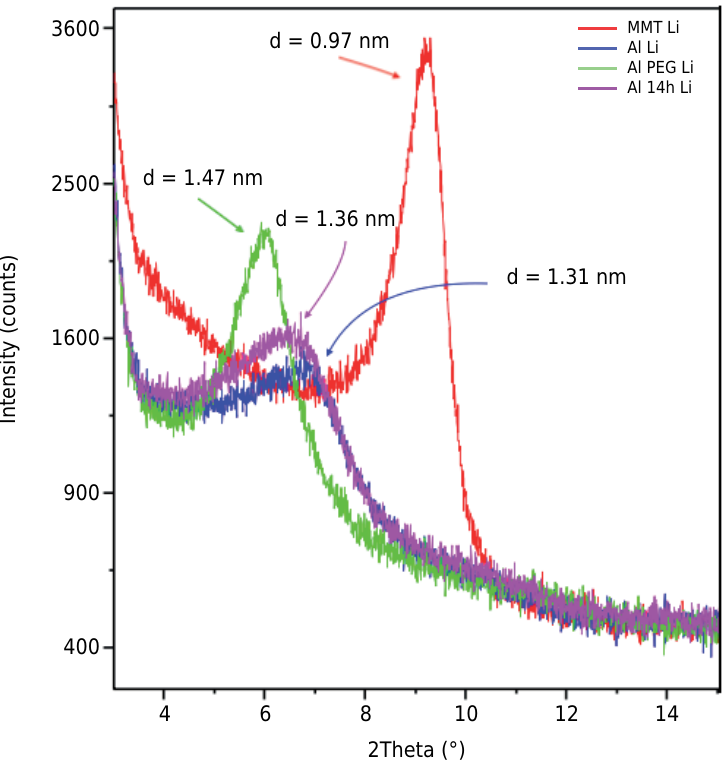
Figure 7. Comparative XRD between MMT and pillar samples, all saturated with Li + and heating at 250